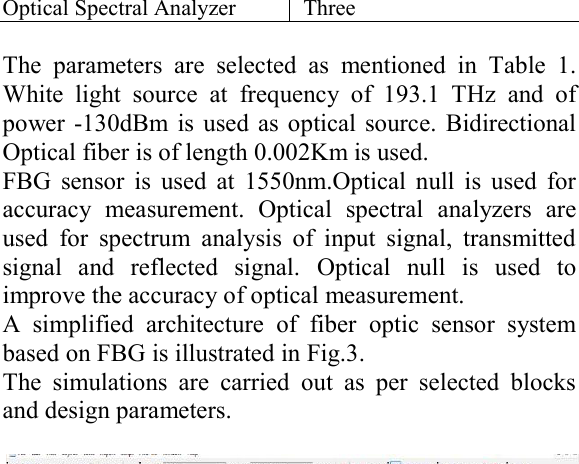
Fig. 4. Power spectrum of Input signal